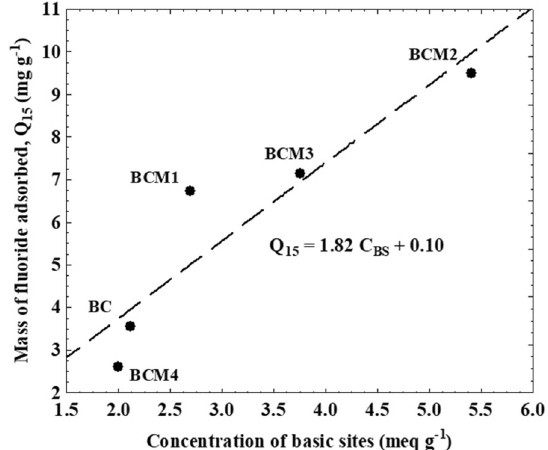
Fig. 8 Effect of the concentrations of basic sites (C BS ) upon the capacity of BC and BCMs for adsorbing fluoride from aqueous solution at T 25 °C and pH 7 = =